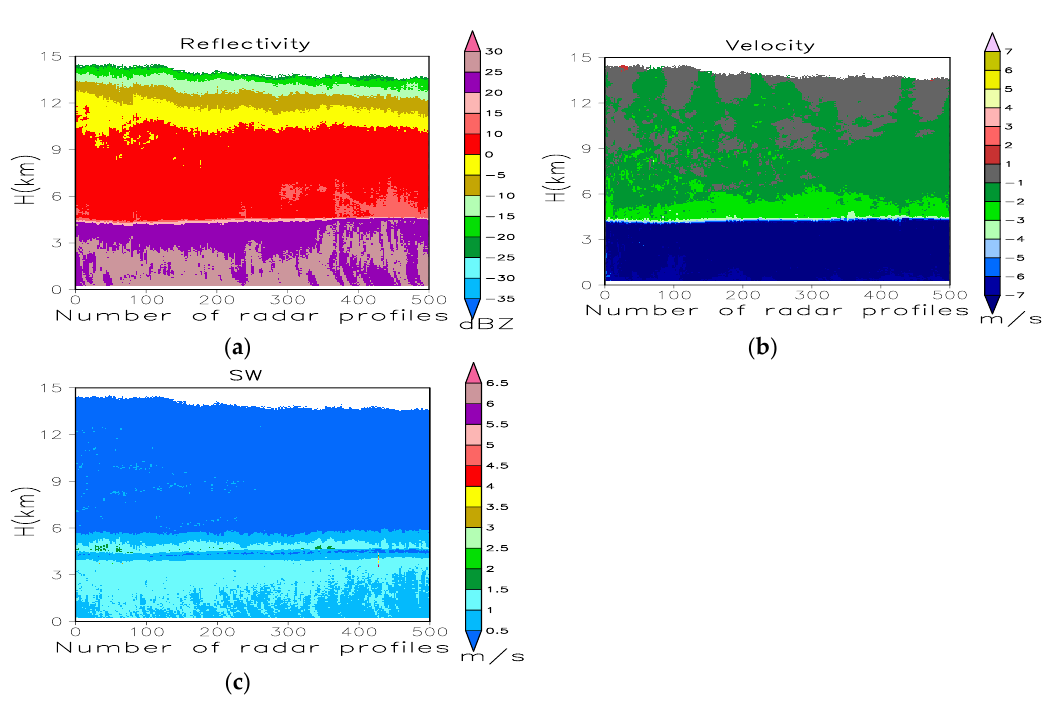
Figure 9. Recalculated ( a ) reflectivity, ( c ) radial velocity, and ( e ) spectrum width only after dealiasing. The corresponding results ( b ), ( d ), and ( f ) after dealiasing and artefact removal from SZ2. The biases of velocity and spectral width introduced by range sidelobe artefacts are shown with the red arrows in ( c ) and ( e ).